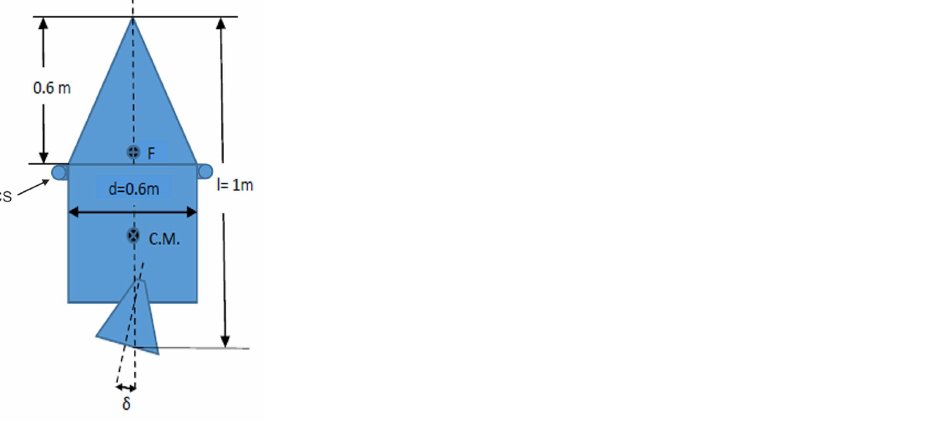
Figure 6. LTV sketch: C.M.—Center of Mass; F—Focus; RCS—reaction control system.